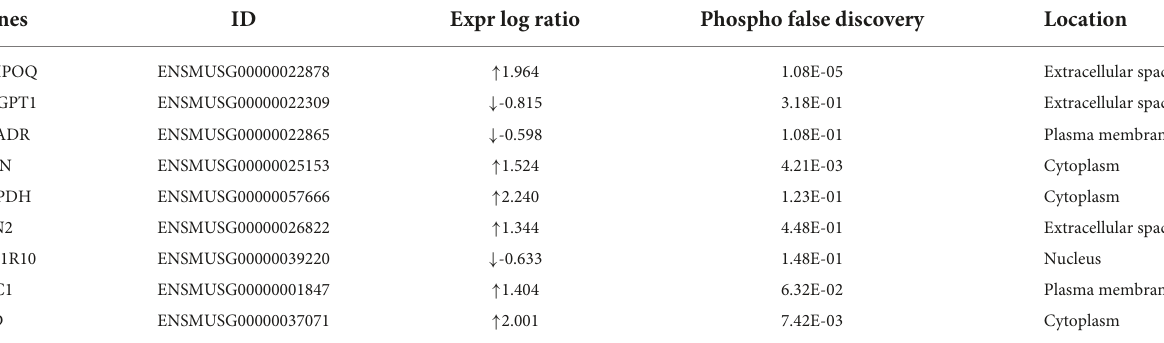
TABLE 1 IPA analysis identifies increase of apoptosis of heart in MYH6-Cre-BDNF − / − heart (activation z -score = 2.028; p = 2.06E-02). Genes ID Expr log ratio Phospho false discovery